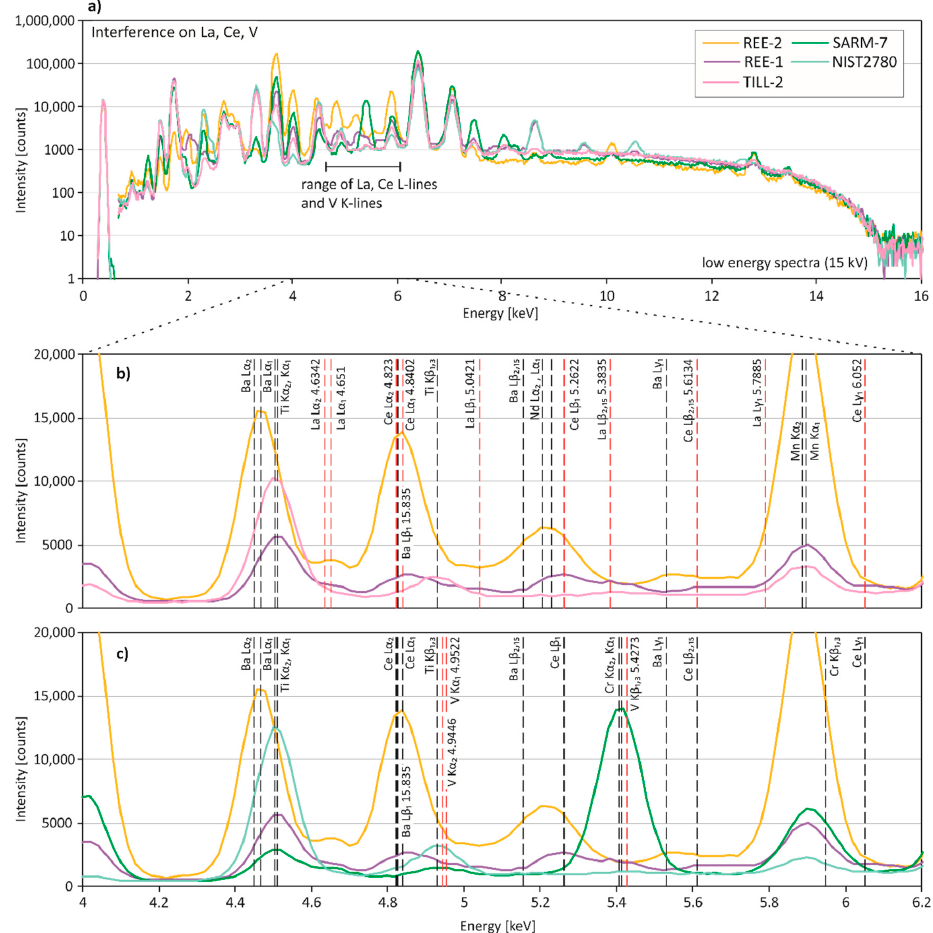
Figure 4. Spectral interferences on La, Ce and V. ( a ) Low energy region (0–15 keV) and ( b , c ) close-up of representative X-ray fluorescence spectra for pXRF measurements of REE-1, REE-2, TILL-2, SARM-7, and NIST 2780. ( b ) La and Ce L-lines are shown in red, additional L- and K-lines of interfering elements in black. ( c ) V K-lines are shown in red, and L- and K-lines of overlapping elements are in black. Excitation energy of the measurements was 15 kV.